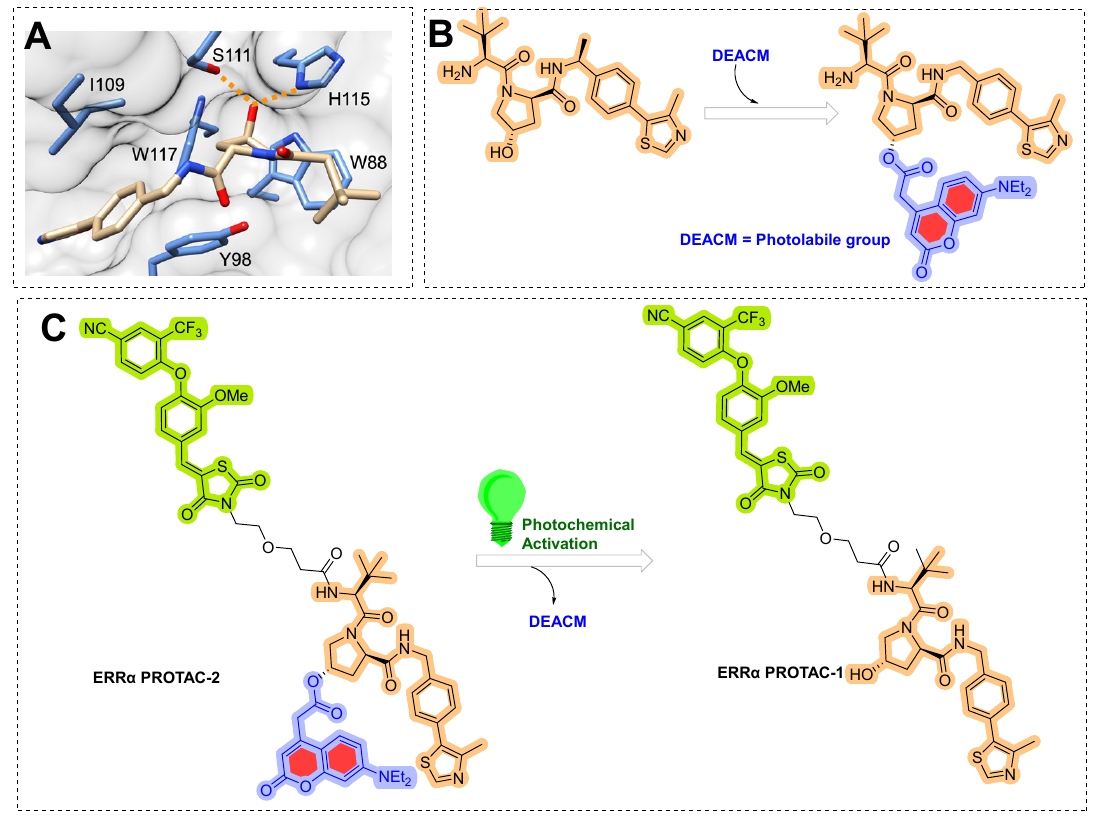
Figure 21. ( A ) Cocrystals VHL ligand binding to VHL E3 ligase, showing critical residue involve- ment in H-bonding interactions. ( B ) Chemical transformation of VHL ligand into coumarin-photocaged VHL ligand. ( C ) photochemical transformation of ERR α PROTAC-2 to ERR α PROTAC-1 .